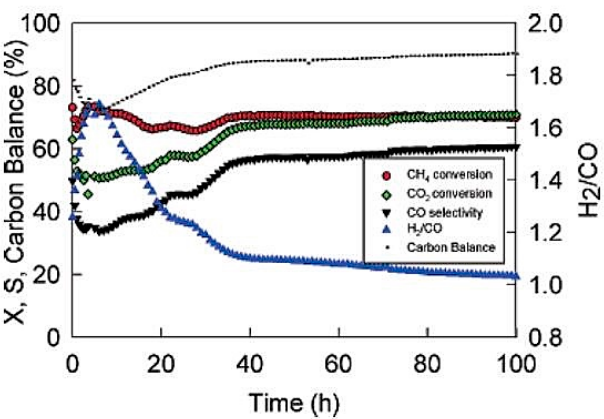
Figure 7. Catalytic performance of Co 6 W 6 C at 850 °C and 3.4 bar adapted with permission from [77] Copyright (2005) American Chemical Society.